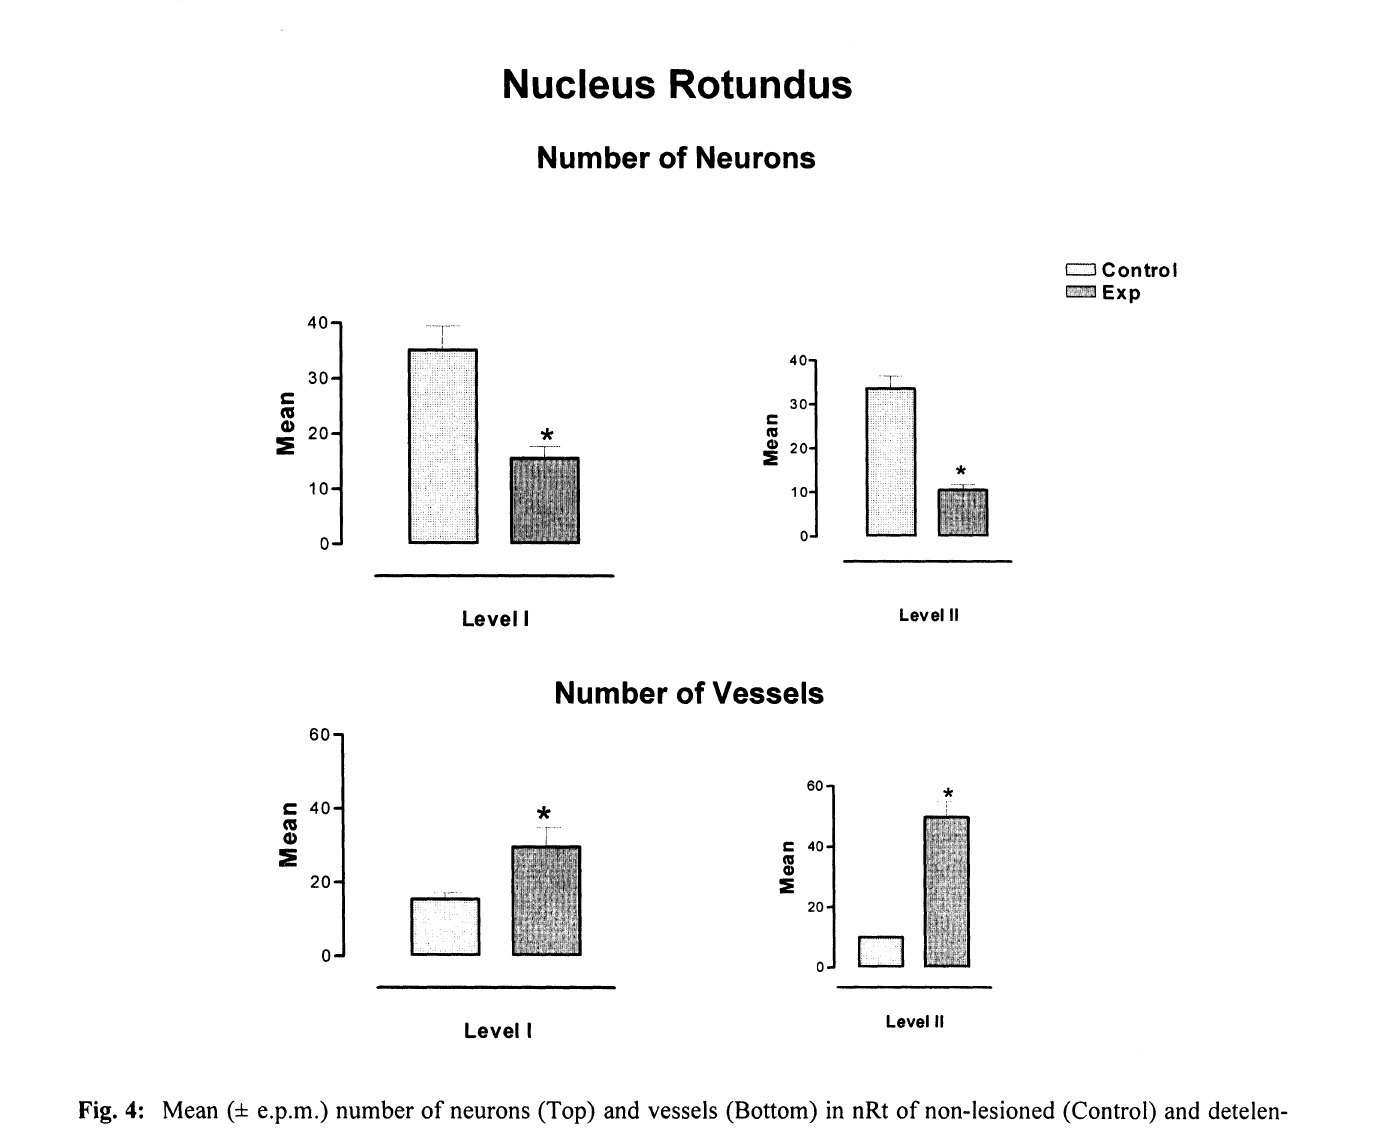
Fig. 4: Mean (+ e.p.m.) number of neurons (Top) and vessels (Bottom) in nRt of non-lesioned (Control) and detelen- cephalated groups (Exp). Measurements were carried out for levels and II.*